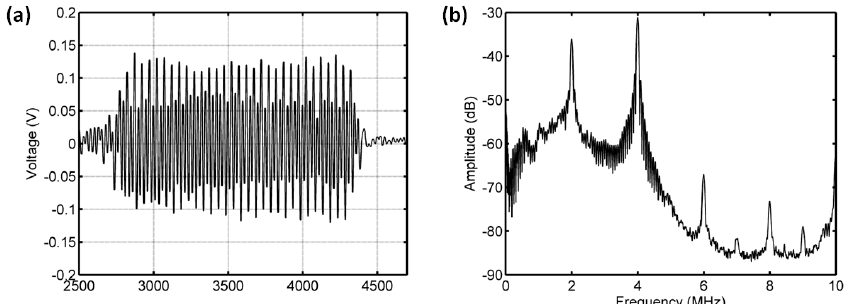
Figure 11. The measured scattering signals from microbubbles and the averaged power spectrum of 50 received signals. ( a ) A single received signal, ( b ) the averaged power spectrum. The driving frequency was 4 MHz, the acoustic pressure was 450 kPa, and the overpressure was 8 mmHg.